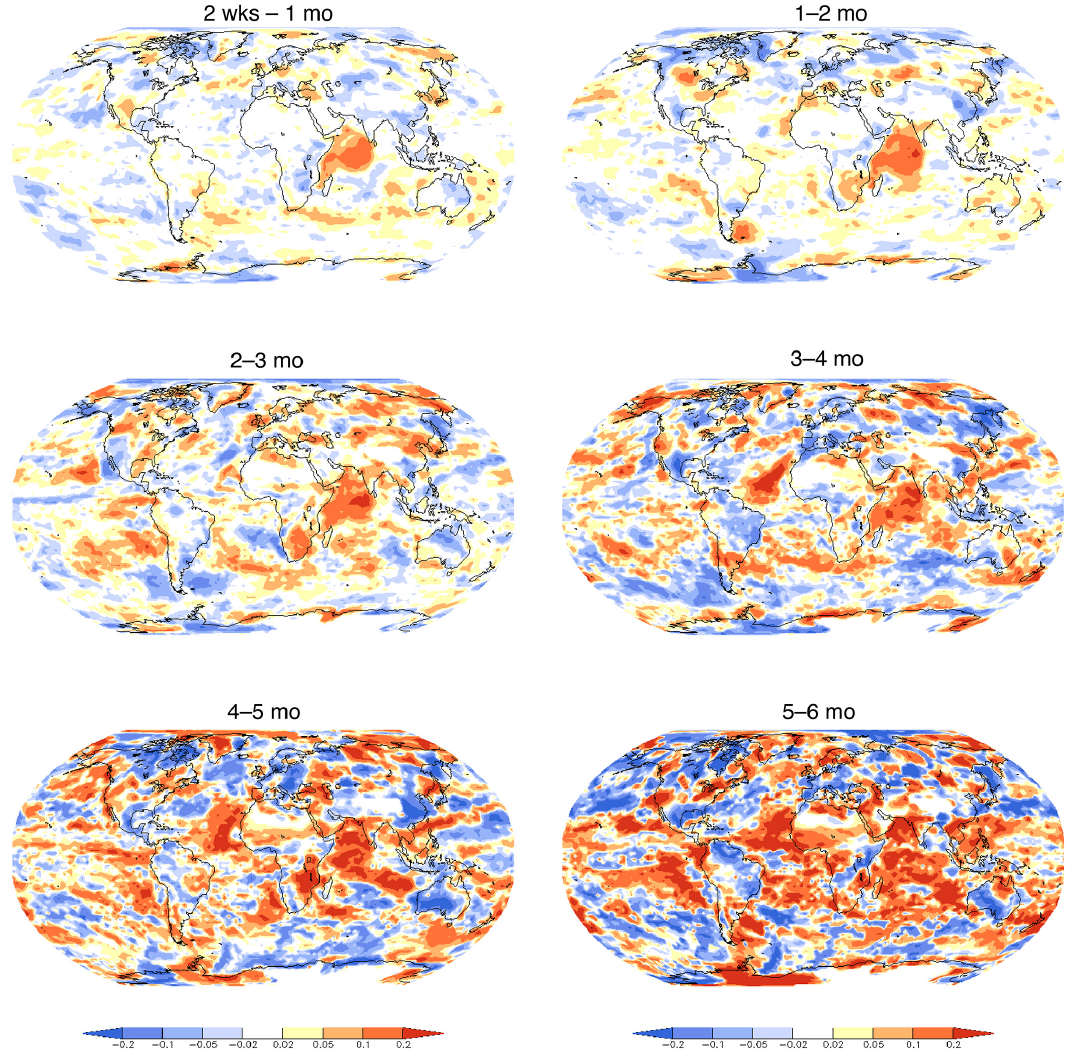
Figure 6. Sensitivity of low cloud fraction to a 1K temperature perturbation to the northwest Indian Ocean (see Fig. 2). Different panels were calculated from projections on band-pass-filtered time series (see Sect.